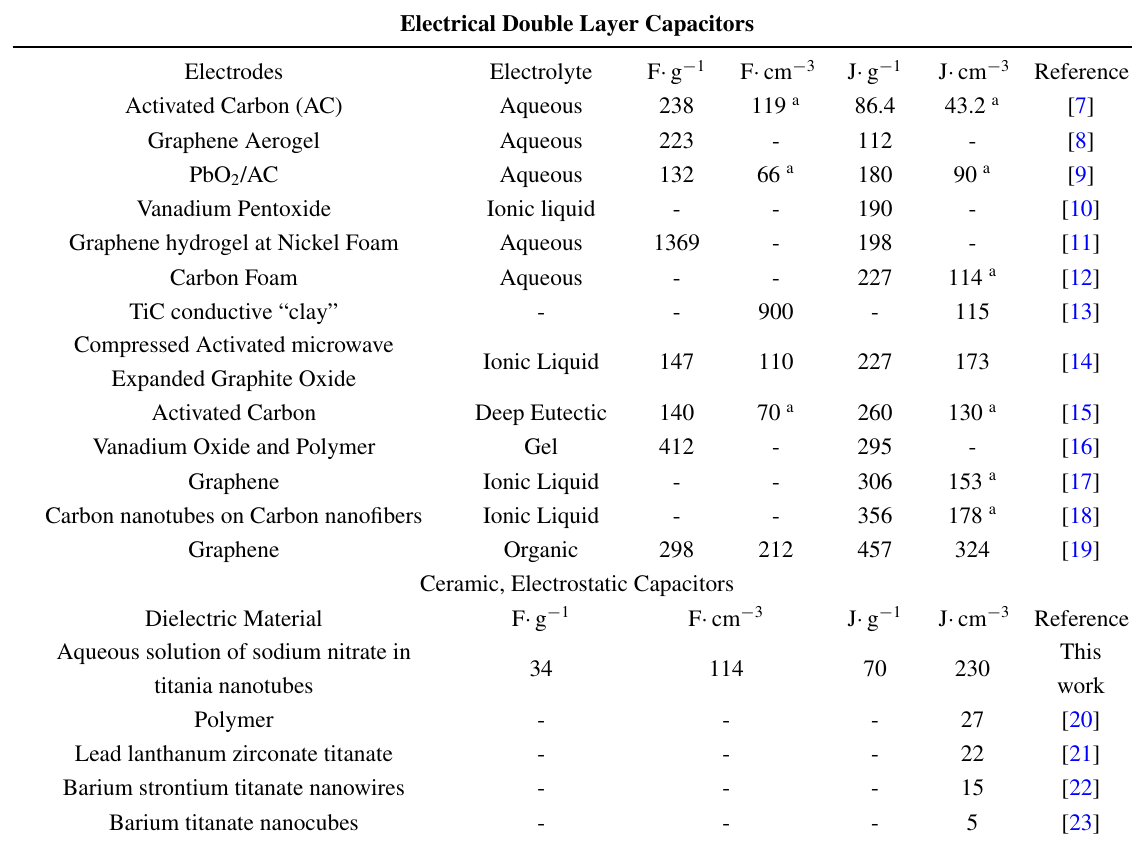
Table 3. Recent advances in high energy storage capacitors. Tube super dielectric materials (TSDM) are on par with EDLCs and far above ceramic